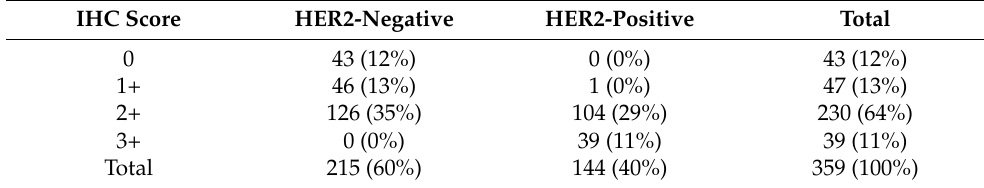
Table 1. Distribution of IHC scores and HER2 status in the training dataset.